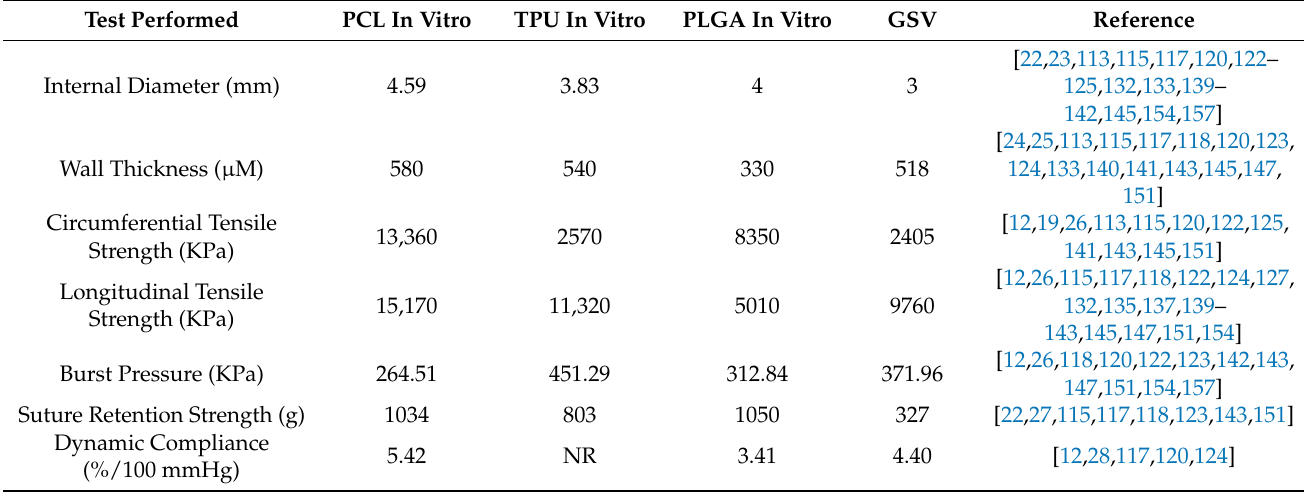
Table 6. Mechanical properties in blood vessels: PCL, TPU, and PLGA tested in vitro (PCL in vivo) and great saphenous vein